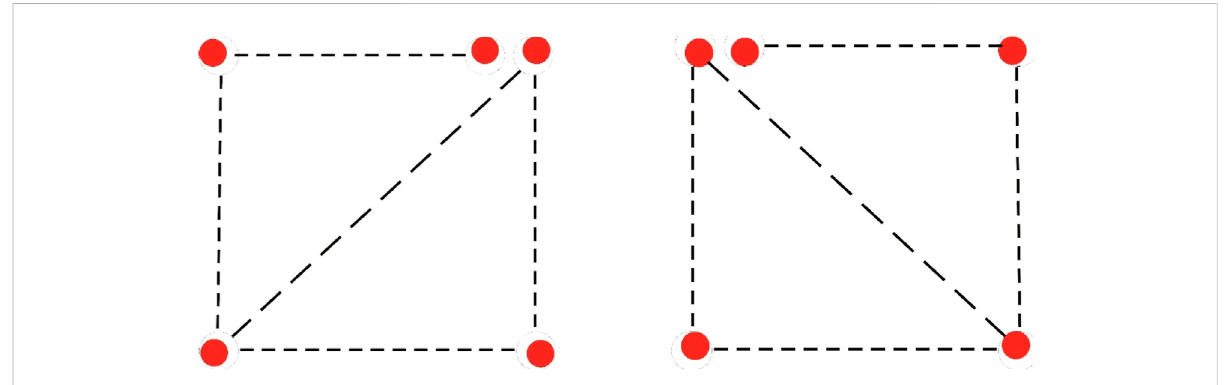
FIGURE 6 Extreme positions of rods within a lattice.